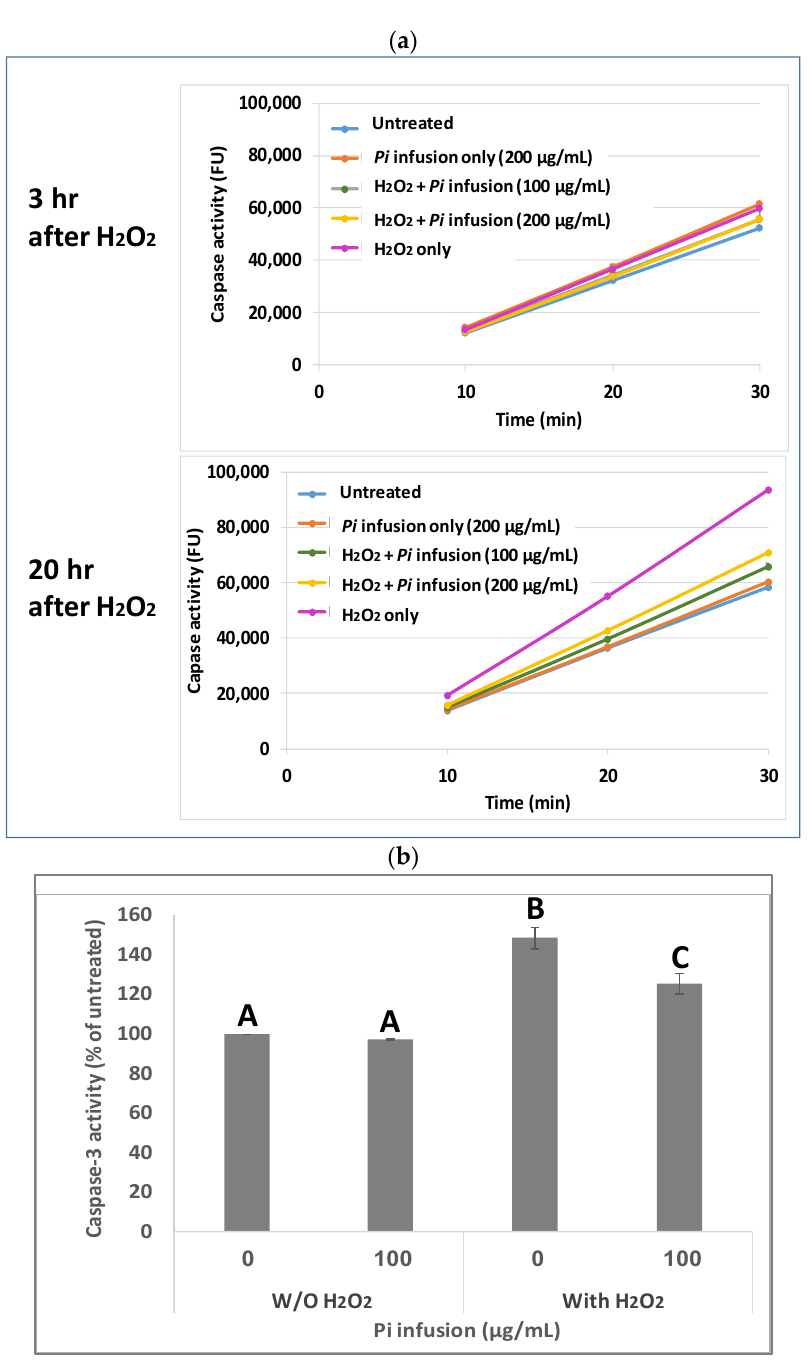
Figure 3. Pi infusion inhibits caspase 3 activity in neuronal cells exposed to hydrogen peroxide. Cells were pretreated with Pi infusion for 2 h before exposure to 200 µM H 2 O 2 . ( a ) Caspase 3 activity in cell lysates (20 µg) was measured (for 30 min) 3 h and 20 h after the induction of oxidative stress. The results are presented as mean ± SD of one experiment with two repetitions. ( b ) Caspase 3 activity in cell lysates (20 µg) was measured 20 h after the induction of oxidative stress for 30 min. The results are presented as mean ± SEM and represent three independent experiments ( n = 6). The results were analyzed by one-way ANOVA followed by the Tukey–Kramer multiple comparisons test. Columns marked with different letters (A, B, C) represent statistically significant differences. ( p < 0.05) .